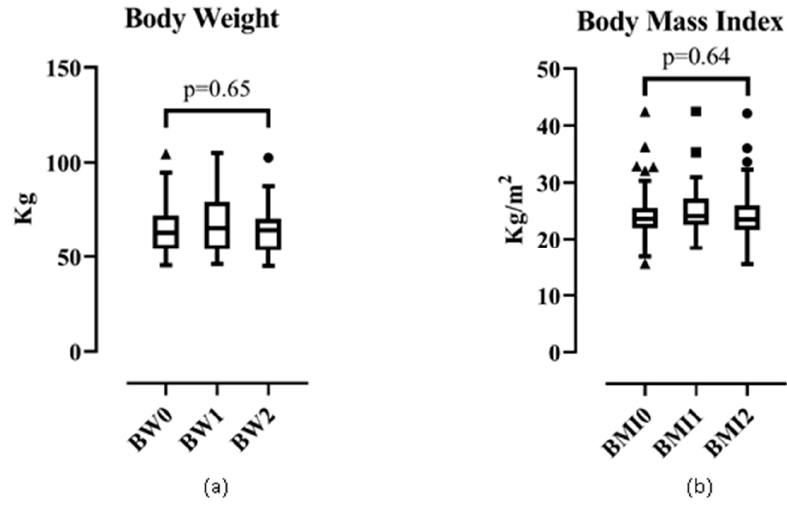
Figure 1. Trend of ( a ) body weight and ( b ) body mass index.